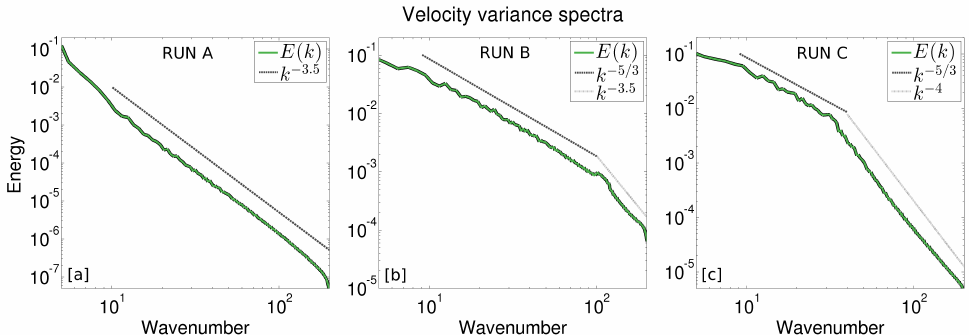
Figure 1. The kinetic energy spectra of the three model runs. Run A, which is characterized by a an enstrophy inertial range is shown in panel ( a ). Run B, which exhibits an energy inertial range, is shown in panel ( b ). Run C, in which the spectrum exhibits an energy inertial range between approximately k = 10 and 30 ( k − 5/3 spectrum), and an enstrophy inertial range at wavenumbers exceeding k = 40, is shown in panel ( c